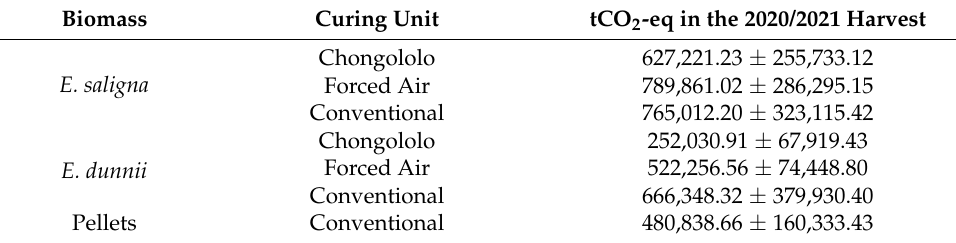
Table 5. Quantification of carbon emissions considering the different